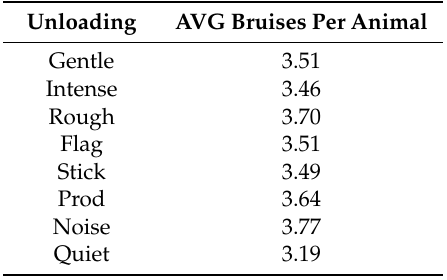
Table 3. Average number of bruises per animal with the various ways of unloading.